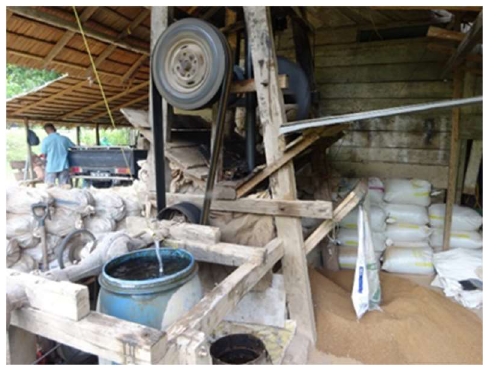
Figure 5. Process of grinding primary rock deposits (hard rock).